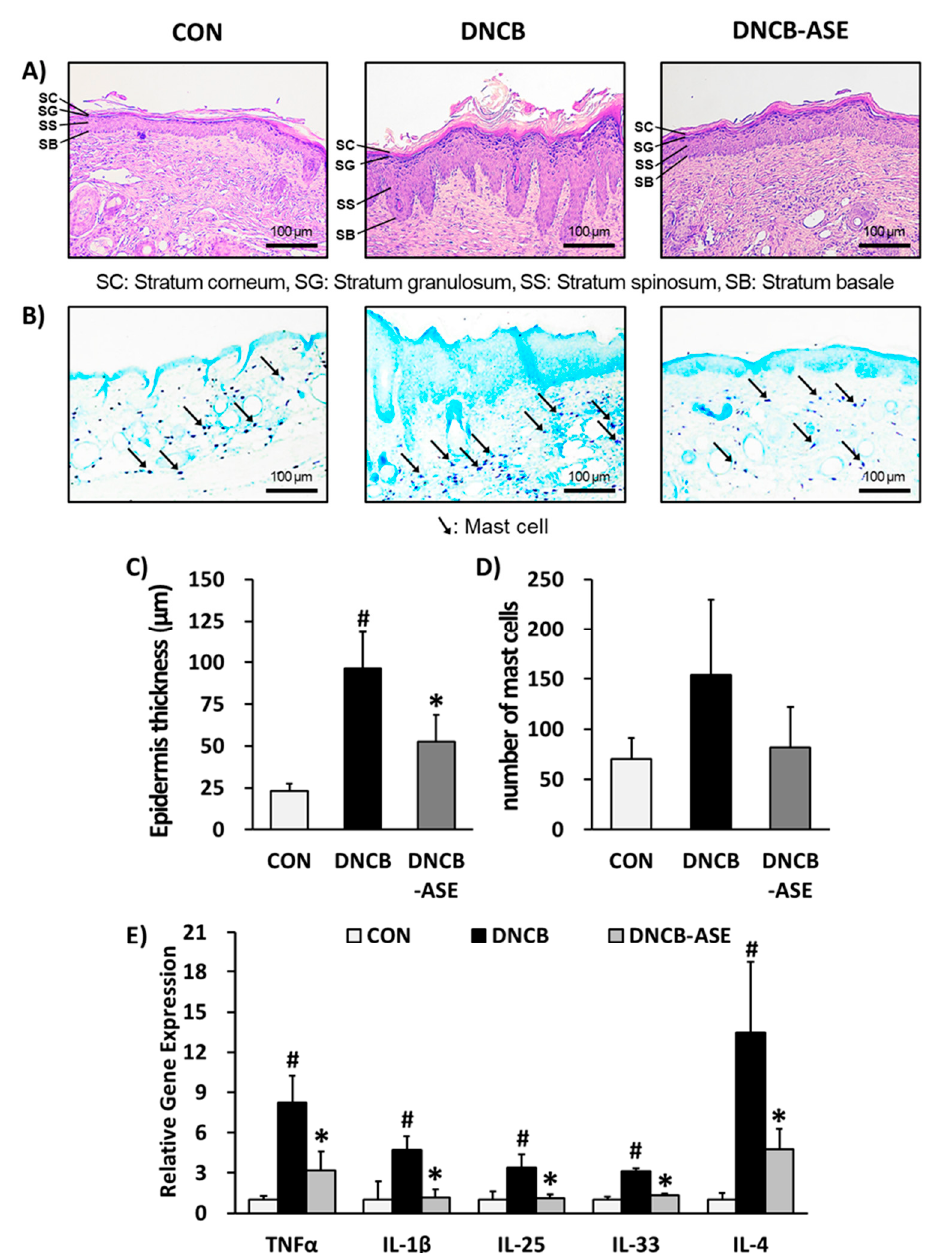
Figure 3. Histopathological effects of ASE in a DNCB-induced atopic hairless mouse model. Hematoxylin and eosin staining (200× magnification, ( A ). Toluidine blue staining ( B ). Epidermis thickness ( C ). Number of mast cells ( D ). Relative gene expression of cytokines (TNF α , IL-1 β , IL-25, IL-33, IL-4) ( E ). Data are presented as the mean ± SD, and were analyzed using a one-way ANOVA and a Tukey’s multiple comparisons post hoc analysis between the DNCB-induced group (DNCB) and the other groups (CON, DNCB-ASE). # p < 0.05 significantly greater than CON. * p < 0.05 significantly lower than DNCB-ASE. CON, normal control group; DNCB: DNCB-induced group, DNCB-ASE: DNCB and acorn shell extract-treated group.